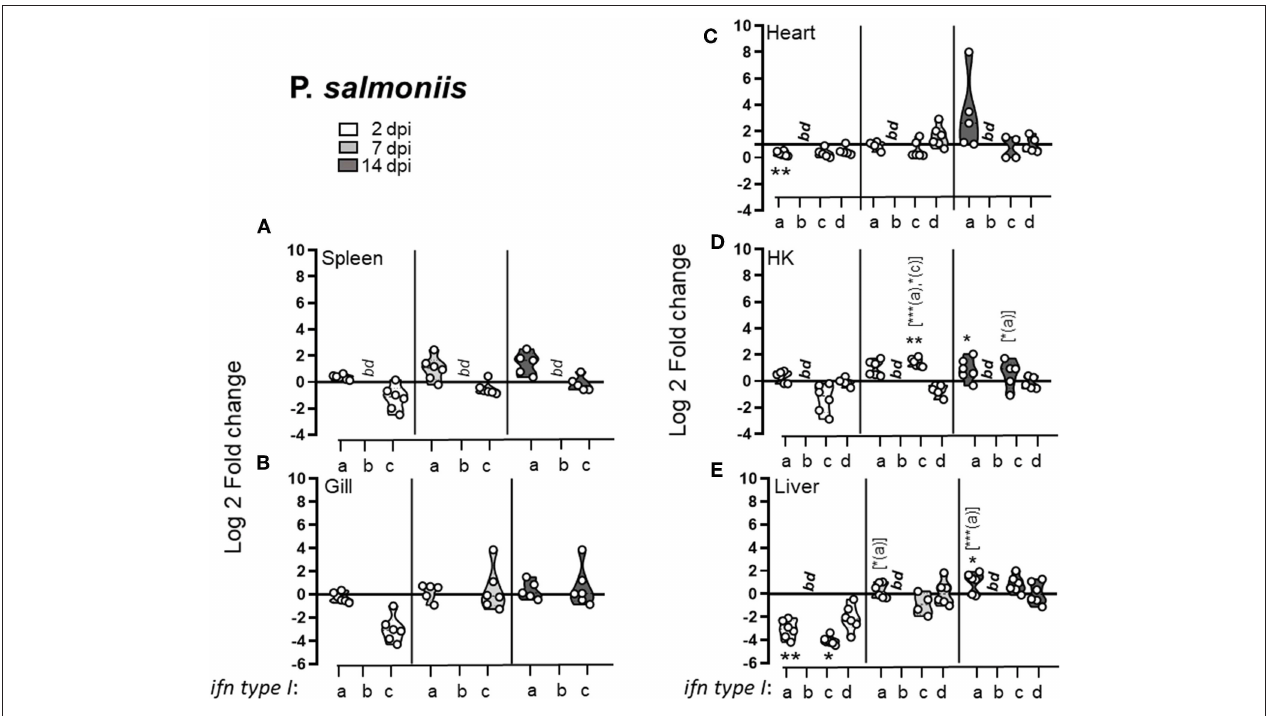
FIGURE 4 | Piscirickettsia salmonis infection leads to early downregulation of the type I IFN response. Pre-smolt Atlantic salmon were intra peritoneal (i.p) injected with 3 × 10 6 CFU P. salmonis or an equivalent volume of PBS and samples were collected at 2, 7, and 14 days post infection. Log 2 fold change of type I IFNa; IFNb, IFNc, and IFNd in different tissues; (A) spleen, (B) gill, (C) heart, (D) head kidney (HK), and (E) liver at different times post challenge [ n ǫ (5;6)] relative to the control groups from the same time point [ n ǫ (5;6)] is shown. Each dot represents an individual fish and the line intersecting the y-axis at 0 represents the unstimulated control that the fold change of the treatments is in relation to. Asterisks above each violin plot indicates the strength of significance compared to PBS injected controls, and letters above each violin represent statistical differences among the different time points for each individual gene ( a = 3 dpi; b = 7 dpi, and c = 14 dpi), bd , below detection, * p < 0.05, ** p < 0.01, *** p = 0.0001. Primer sequences that are conserved for IFNa1 and IFNa2, for all IFNb and all IFNc subtypes were used (